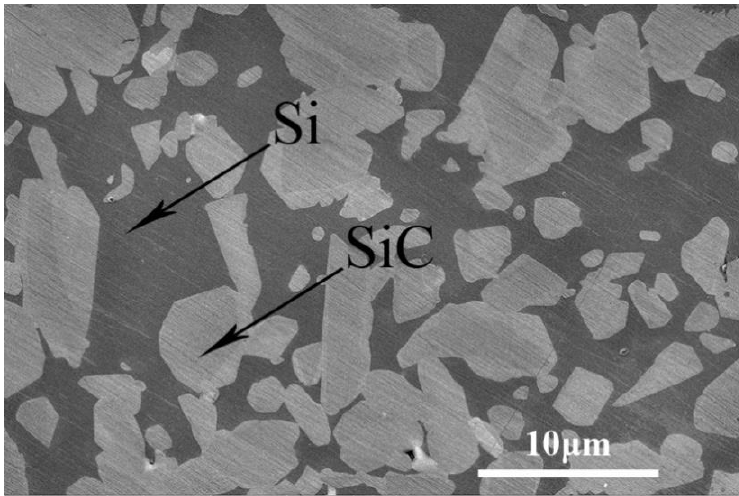
Figure 1. SEM (scanning electron microscopy) image of the initial SiC ceramic.